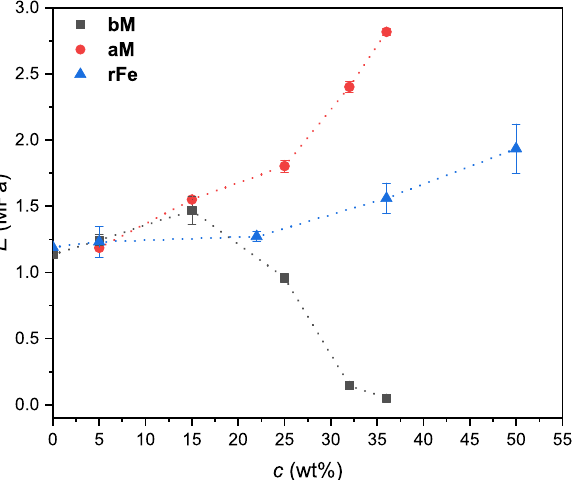
Figure 4. The zero-field Young’s modulus of the MREs with different particle loadings. The dotted line is a guide for the eye. In most cases, the error bar is smaller than the symbol.